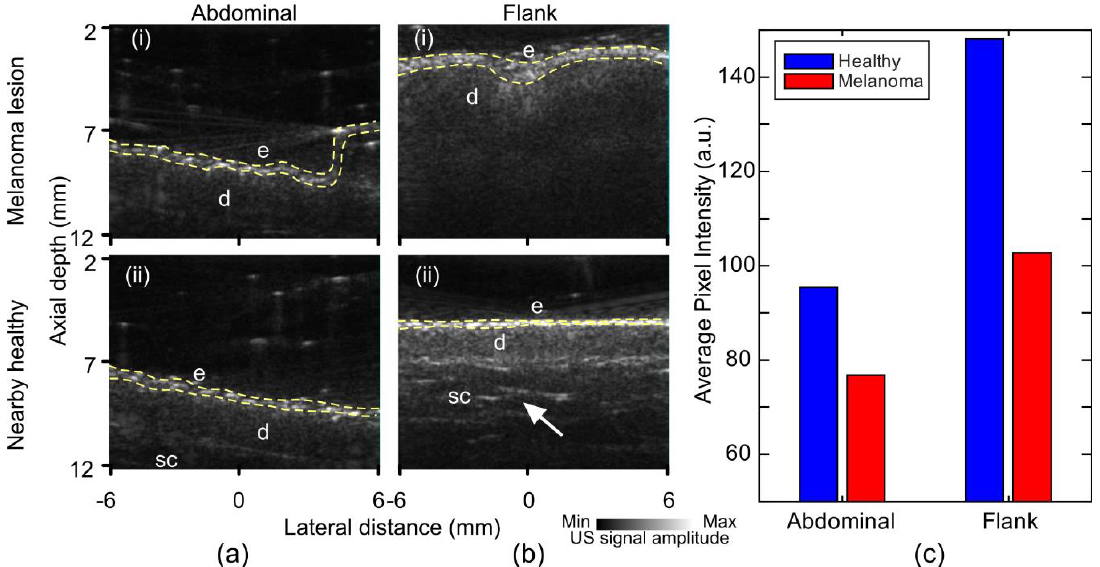
Figure 4. Ultrasound images of melanoma lesion and nearby healthy skin. ( a ) Abdominal: (i) Lesion, (ii) nearby healthy. ( b ) Flank: (i) Lesion, (ii) healthy. ( c ) Bar chart of average pixel intensity from epidermal region of US images. E: Epidermis, d: Dermis, sc: Subcutaneous tissue. Fibrotic septa (arrows), epidermal layer pixels (yellow dashes).